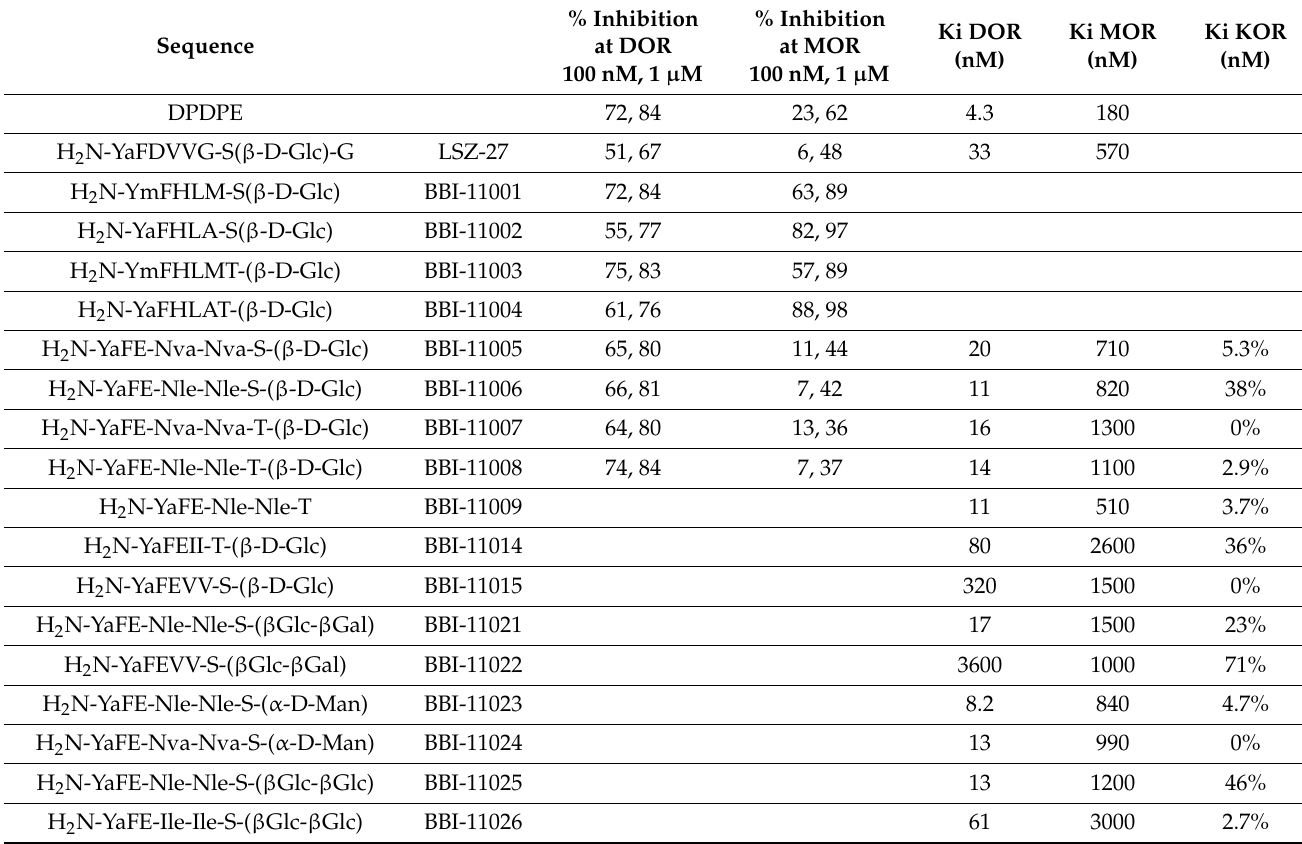
Table 1. Opioid activity of the screened deltorphin